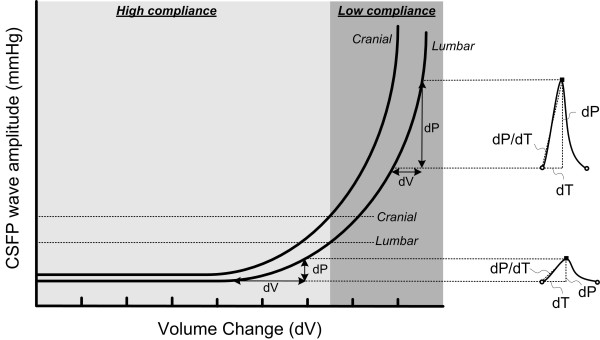
Assessments of intracranial compliance and lumbar compliance during lumbar infusion. This diagram illustrates the intracranial and lumbar pressure-volume curves and the relationship to the pulsatility parameters. Under normal physiologic conditions with high intracranial compliance, ICP wave amplitude is correspondingly small. As intracranial compliance decreases (steep part of the pressure-volume curve), the brain behaves increasingly like a linear elastance and so variations in intracranial volume correlate increasingly well with changes in ICP wave amplitude, thus the steepness of the pressure-volume curve accounts for large-amplitude ICP waveforms. The cranial pressure-volume curve is left of the lumbar pressure-volume curve, illustrating that compliance is higher in the lumbar compartment.